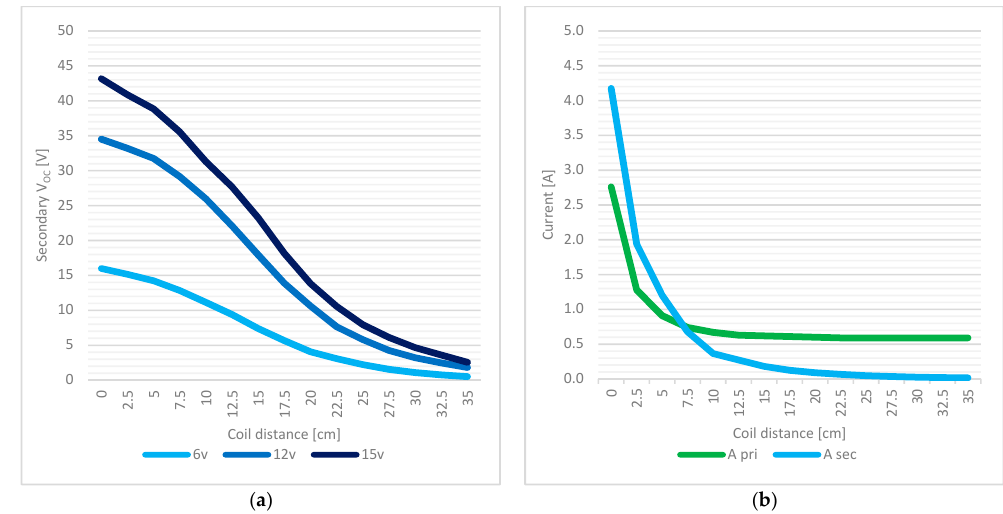
Figure 11. Inductive charging system characterization, free air and coaxial coils (coil distance is in Y direction of Figure 10a): ( a ) the secondary V OC at different primary supplies, ( b ) the I SC compared to primary I SUPPLY .